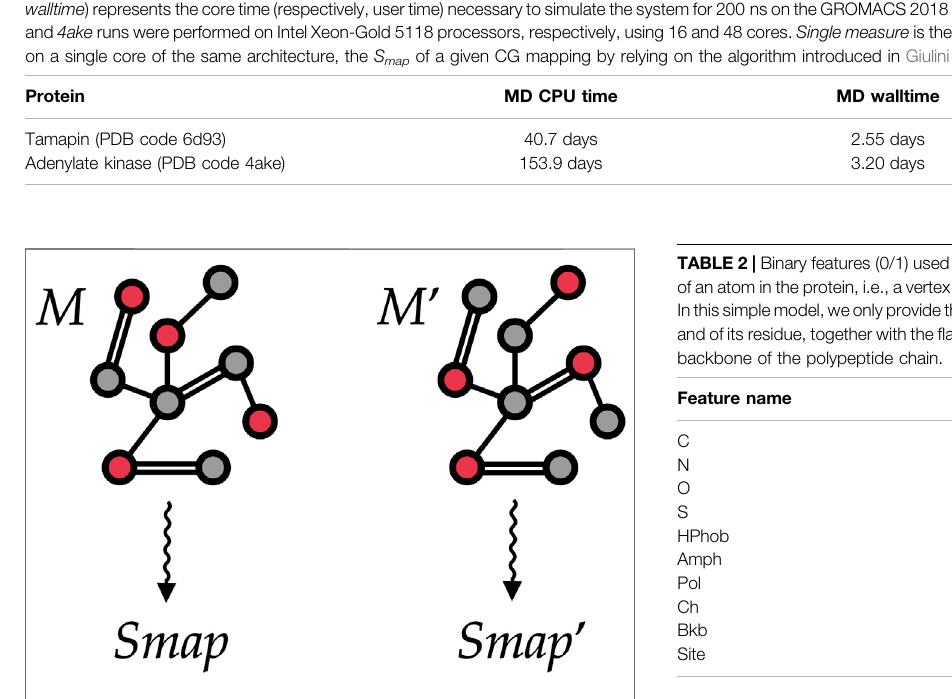
FIGURE5 | Two different mappings M and M ʹ associatedwith the same (schematic) protein structure. To train our machine learning model, we treat each protein as a graph where vertices are atoms and edges are placed among atoms closer than a given threshold. The selected CG sites in each of the two mappings are marked in red and encoded asa vertex feature. Ourgoal istoautomaticallylearntoassociateboth mappingstoproper values S map and S ′ map of the mapping entropy. heavy atom composing the molecule corresponds to a vertex, and edges connect pairs of atoms that in the reference structure are closer than a selected threshold — in our case, 1 nm. At odds with